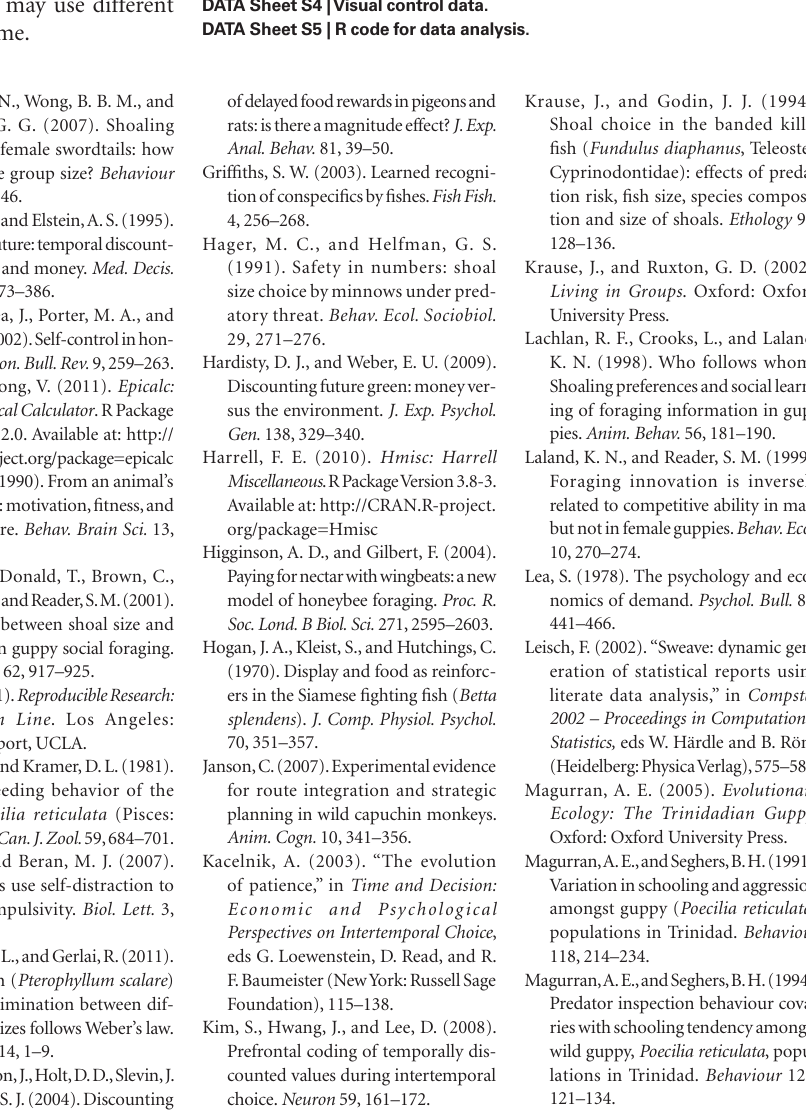
DaTa Sheet S5 | r code for data